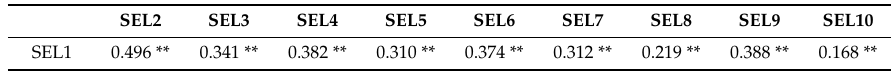
Table A2. Correlation coe ffi cients from Pearson correlation analysis between observed variables in